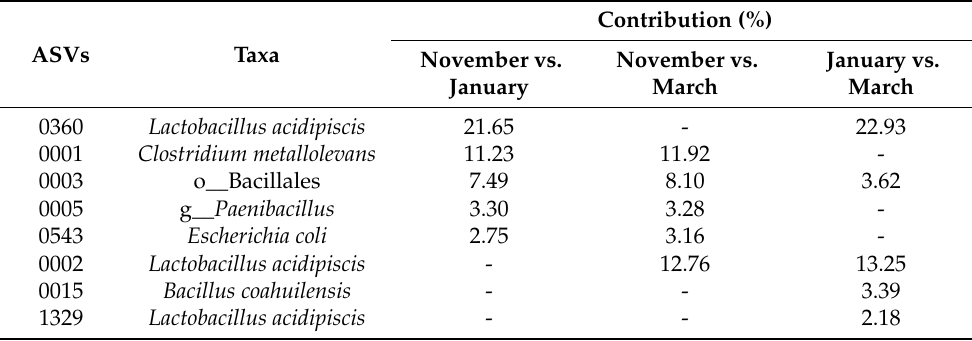
Taxonomic abbreviations: o, order; g,